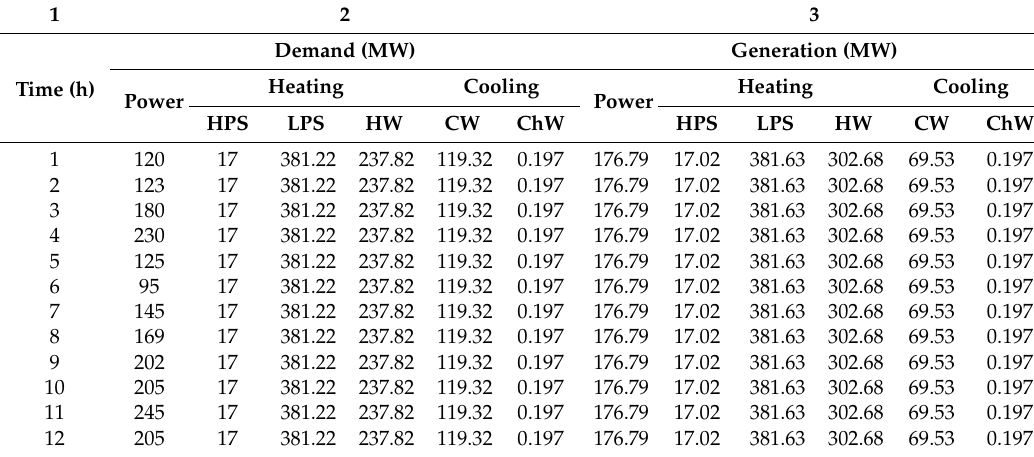
Table A9. TriGenSCA after iteration from 1 to 12 h.